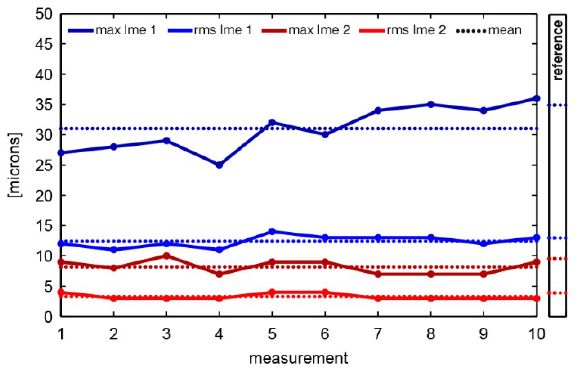
Figure 7. Quality characteristics (typical raw image to JPG conversion and synchronisation)